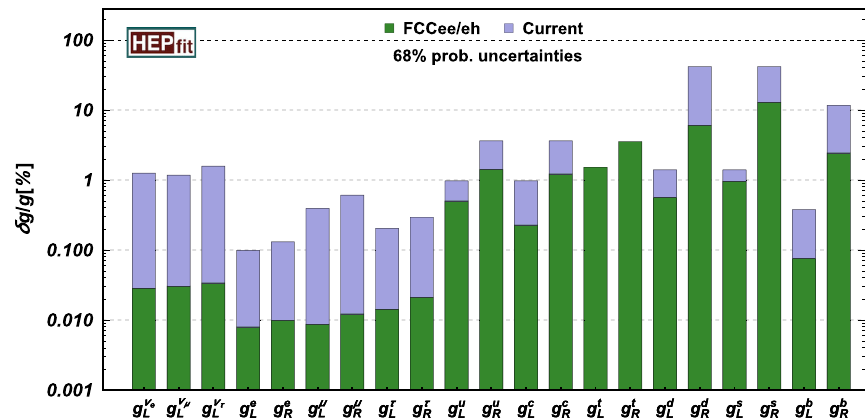
Fig. 8.2 Sensitivity, at the 1- σ level, to deviations of the neutral current couplings resulting from a global EFT fit at the dimension-6 level to EW precision measurements at FCC-ee and